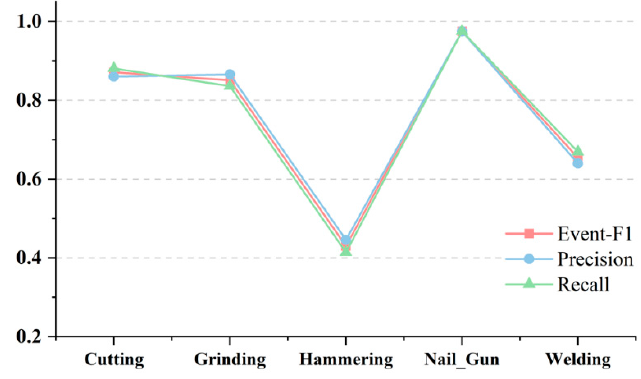
Figure 15. Results for Segment F1, precision and recall.